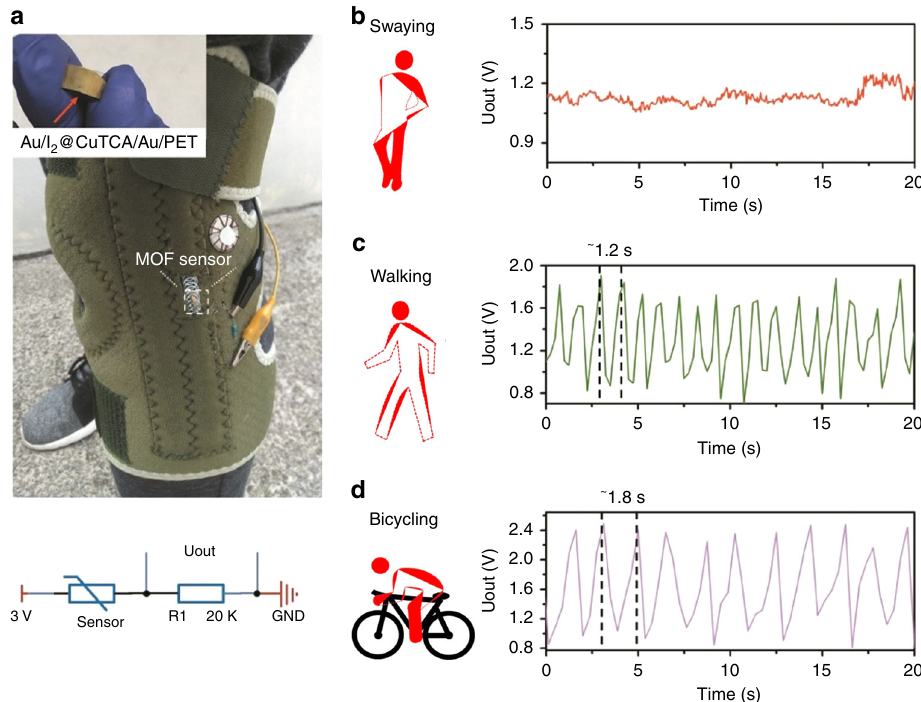
Fig. 6 Human body motion recognition with the I 2 @CuTCA strain sensor. a Schematic of the home-made smart kneecap with integrated MOF sensor, a 20 k Ω resistor (R1) and a button cell. Photo image of the sensor and equivalent circuit of the strain detecting unit are also plotted. Uout stands for the voltage falling on the resistor R1. b – d Strain-responding voltage output signals of the smart kneecap under leg swaying ( b ), walking ( c ), and bicycling ( d ) conditions,